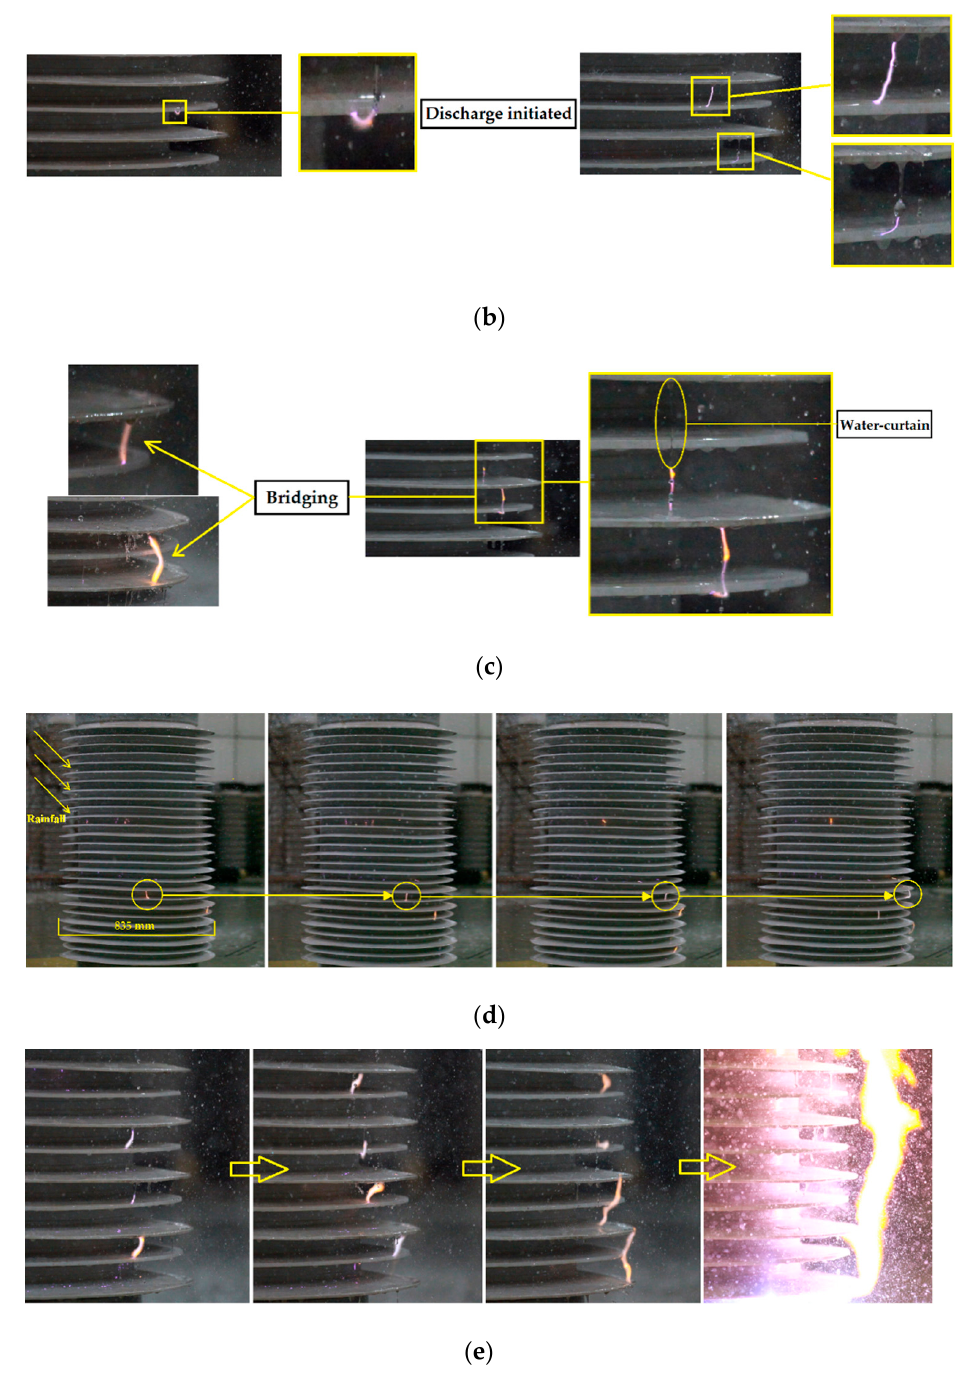
Figure 7. Discharge behavior between sheds of large-diameter post insulators. ( a ) Suspended water-drop and discharge of water-drop on the upper surface; ( b ) discharge initiated; ( c ) bridging phenomenon; ( d ) lateral movement of discharge between sheds of large-diameter post insulators; ( e ) development process of flashover.